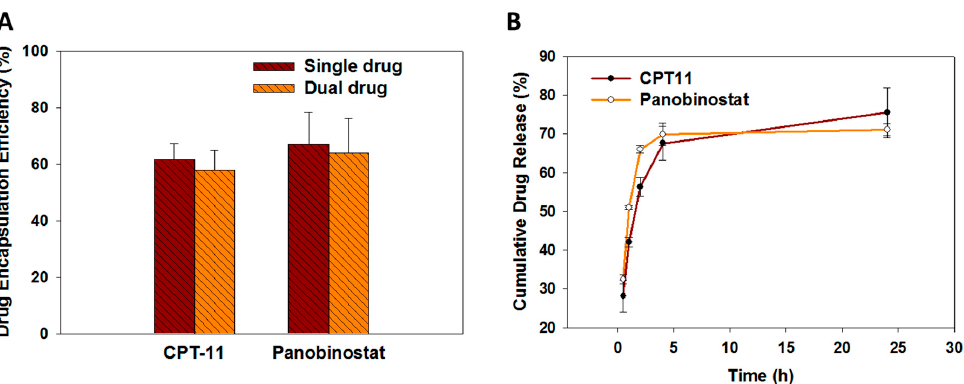
Figure 3. ( A ) The drug encapsulation efficiency of CPT-11 (single drug), panobinostat (single drug) or CPT-11 + panobinostat (dual drug) in immunoliposomes ( n = 5). ( B ) The drug release profiles from CPT-11 and panobinostat-loaded immunoliposomes (ImmuLipCP) at 37 °C in PBS (pH 7.4) ( n =